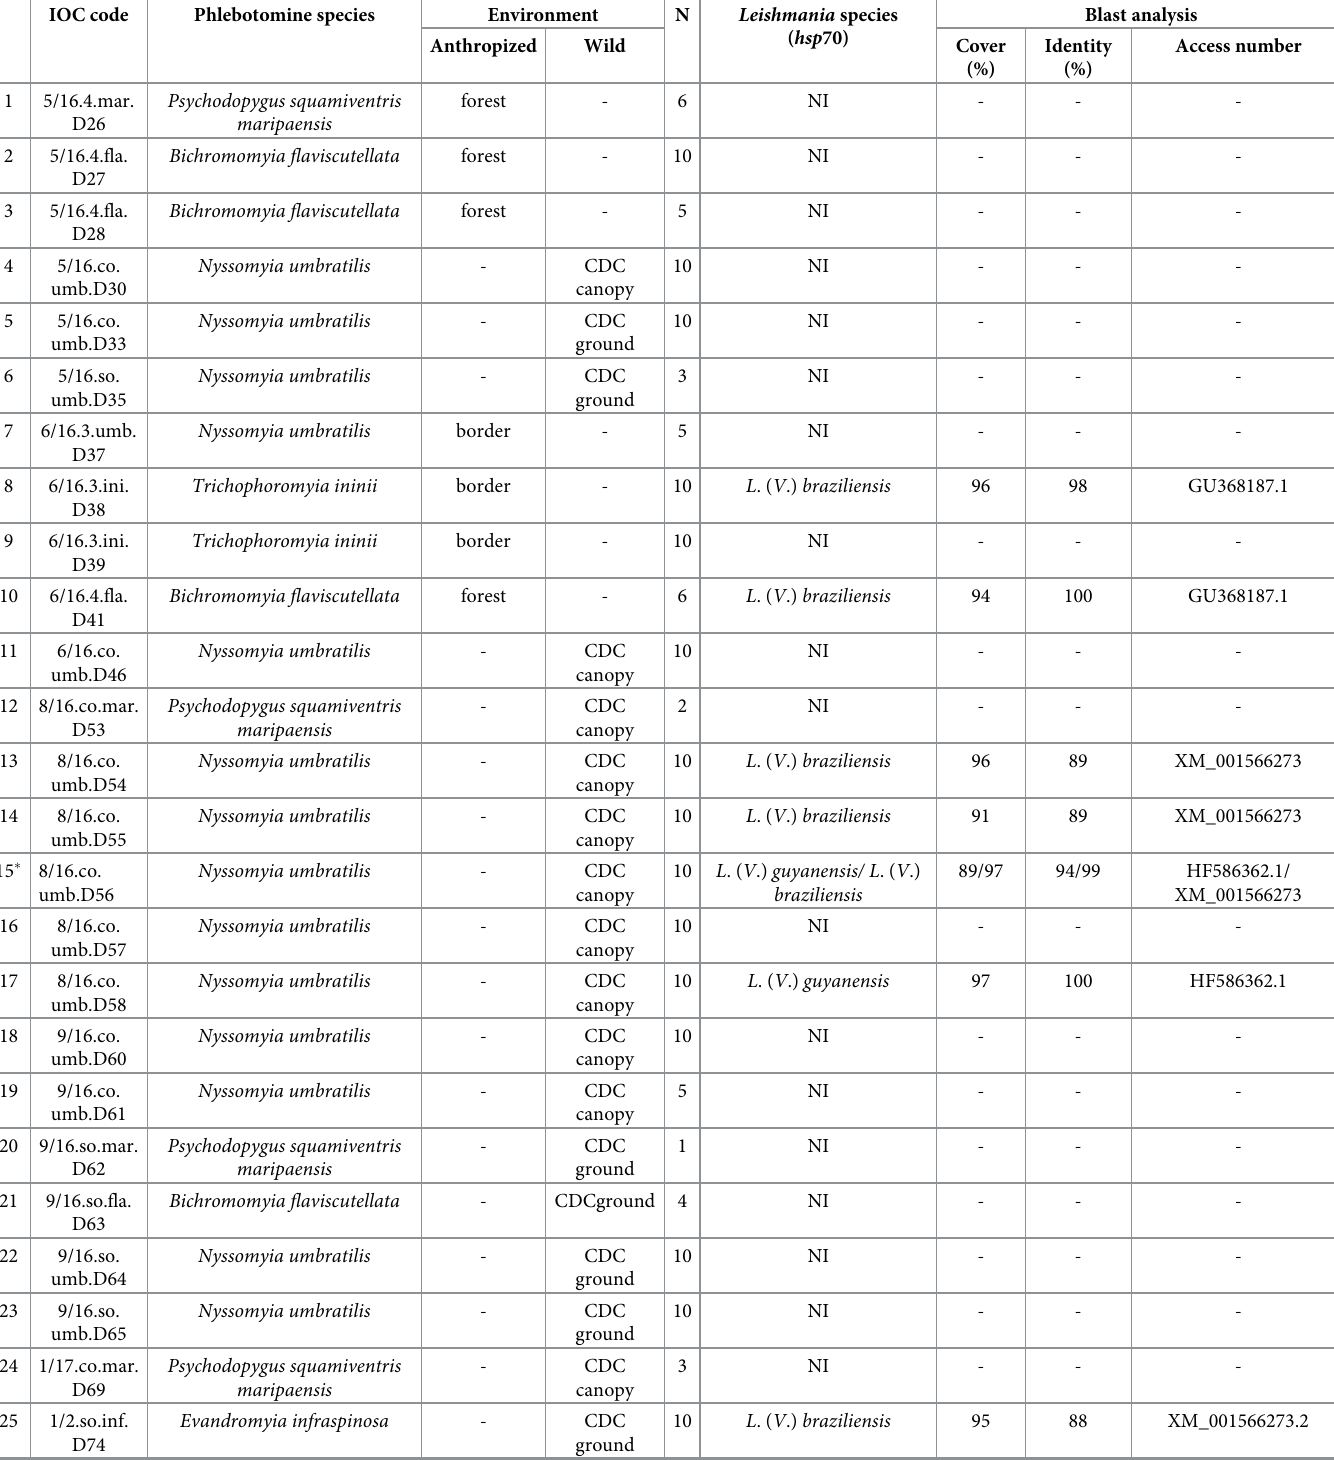
Table 2. Samples of phlebotomines PCR-multiplex-positive for the cacophony gene (Phlebotominae) and for the kDNA gene ( Leishmania spp.) with descriptions of the environment where they were captured, number of specimens analyzed and sequencing